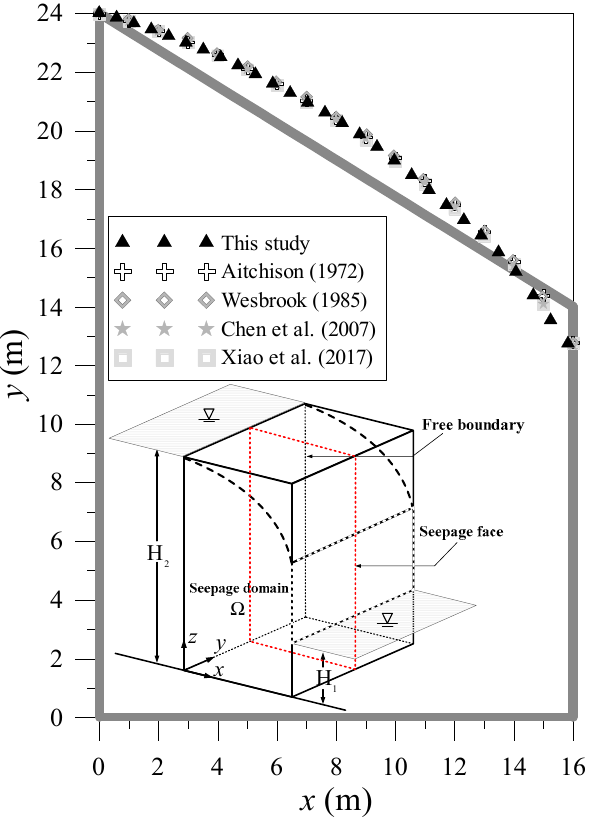
Figure 13. Comparison of the computed results for a rectangular dam on profile y = 2.5. Table 1. Comparison of computed result of the separation point with those from references.